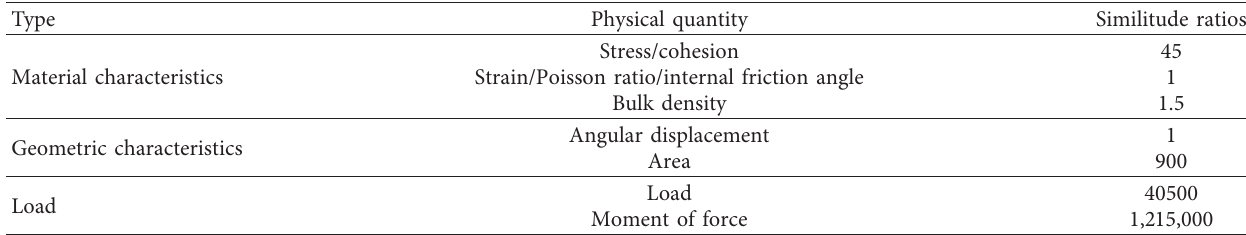
Figure 2: Measuring sensors. (a) Strain gauge. (b) Miniature pressure box. Table 2: Similarity coefficient of other related physical